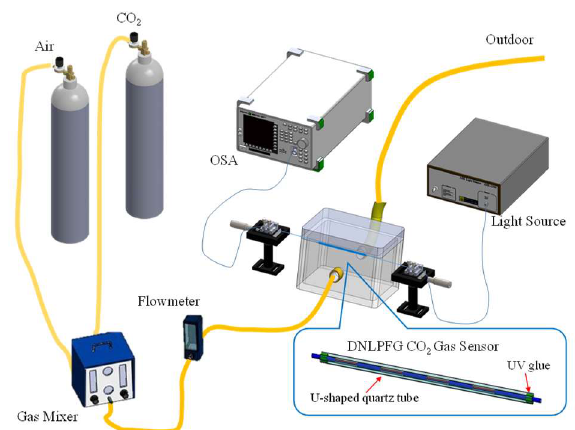
Figure 7 . The experimental setup of CO 2 gas sensing with the sol-gel coated DNLPFG CO 2 gas sensor .